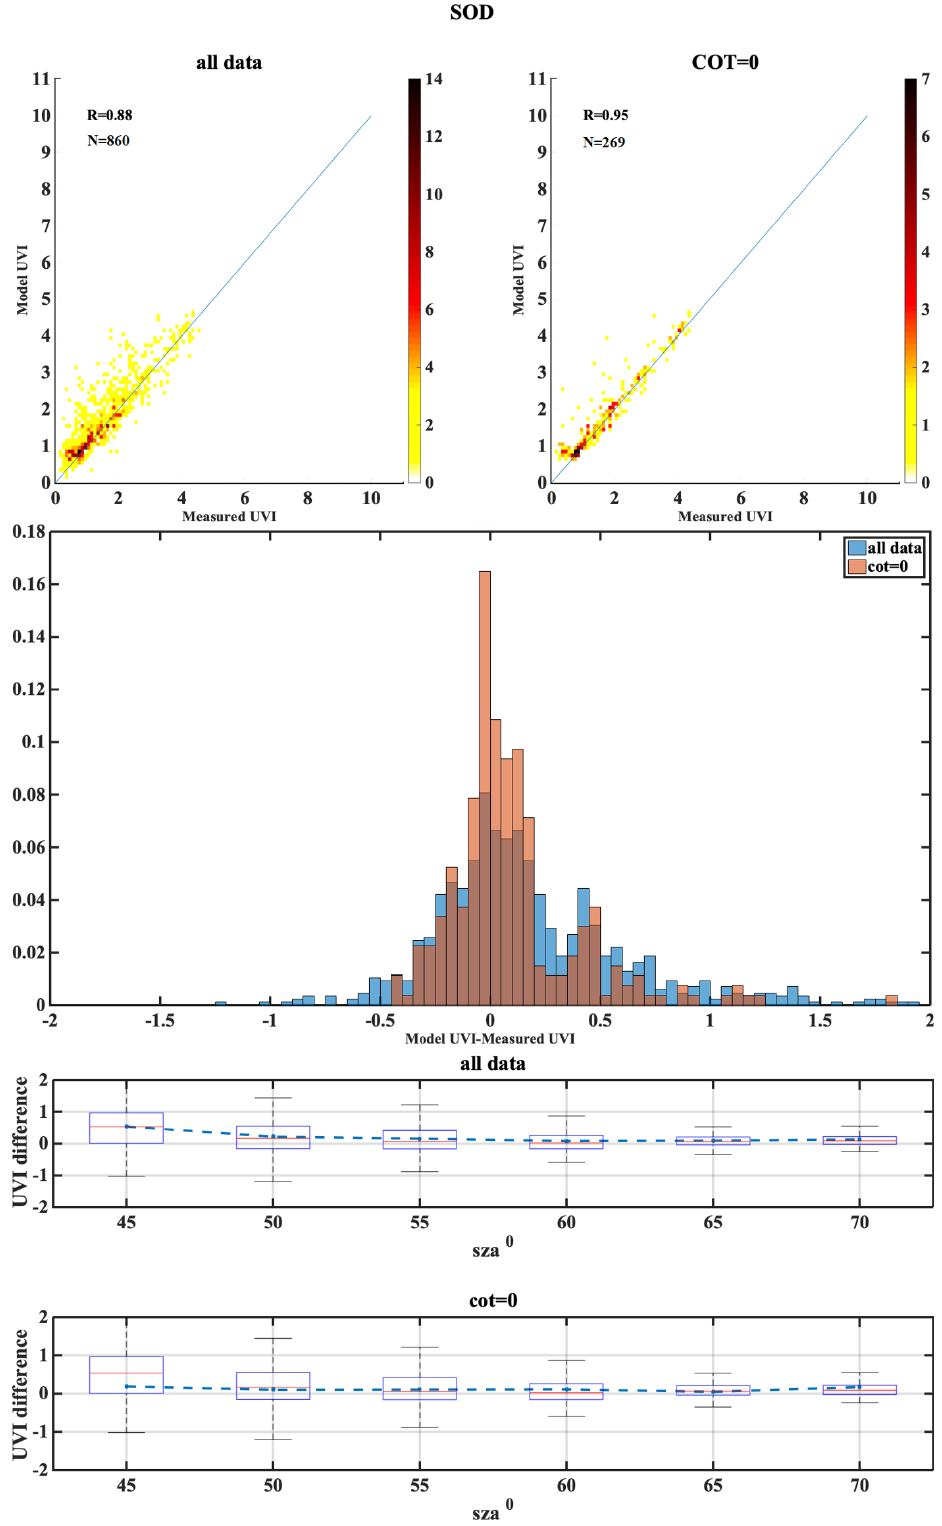
Figure A13. Same as above but for the SOD